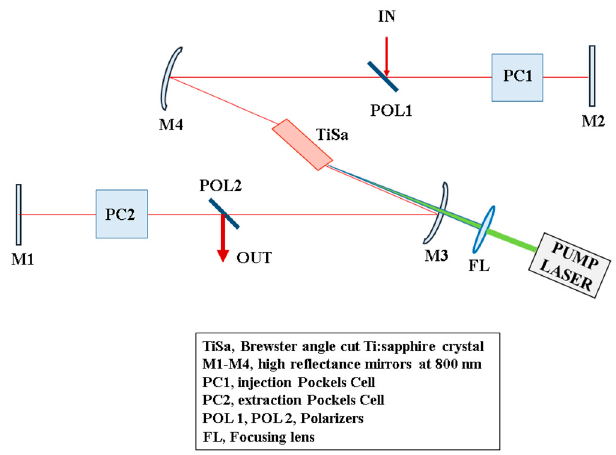
Figure 8. Schematic drawing of a regenerative amplifier with a Ti:sapphire amplifying crystal.